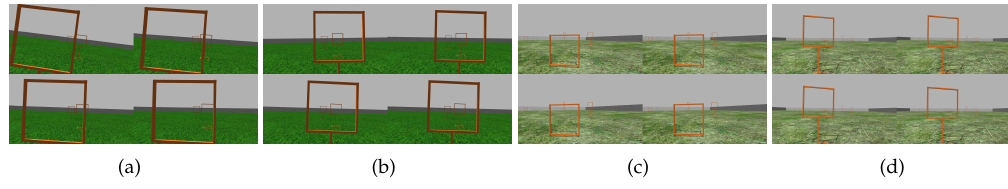
Figure 11. Mosaicimage examples where each mosaic image ( a – d ) is composed of 4 frames.